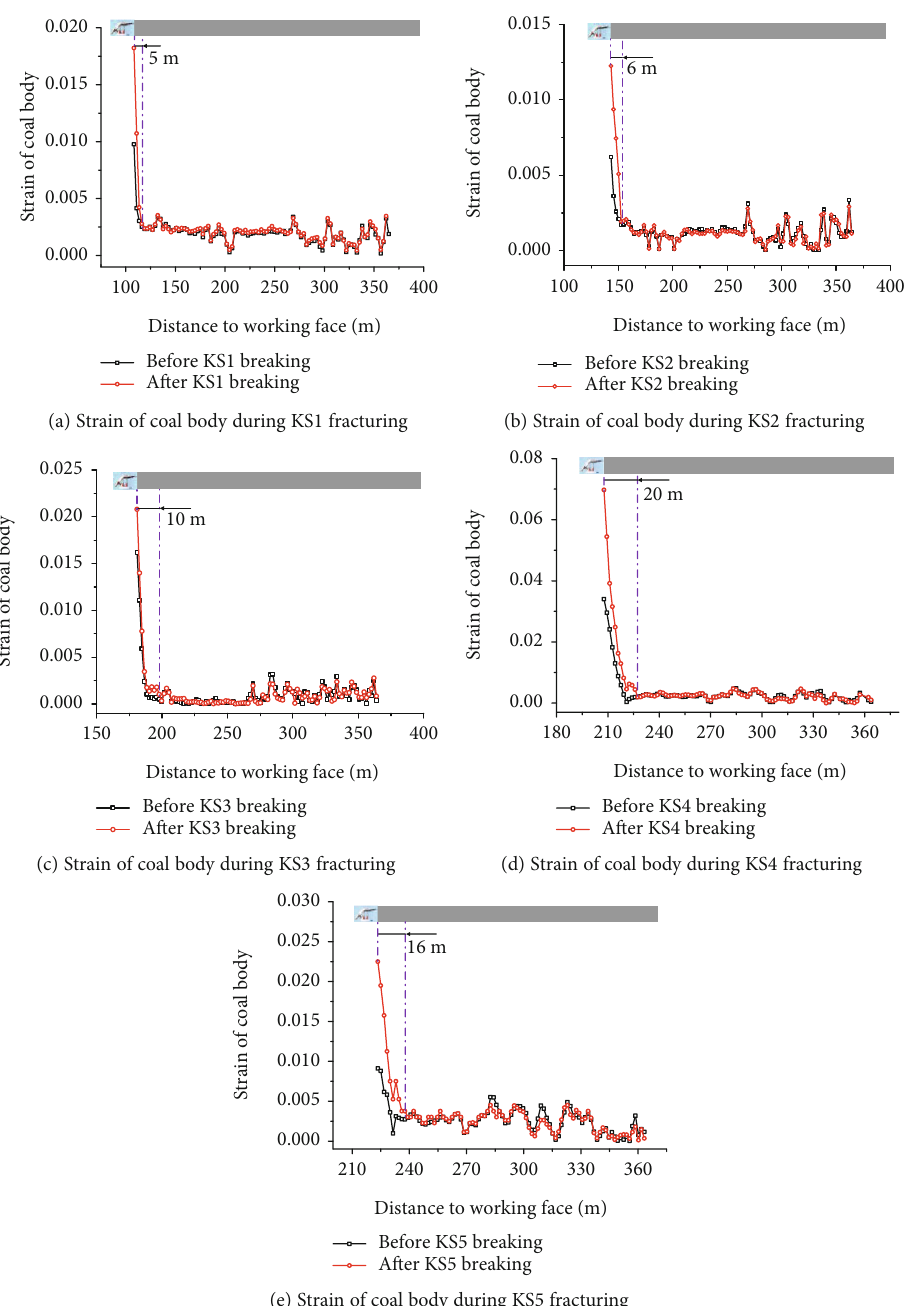
Figure 5: Strain of coal body during fracturing of di ff erent key